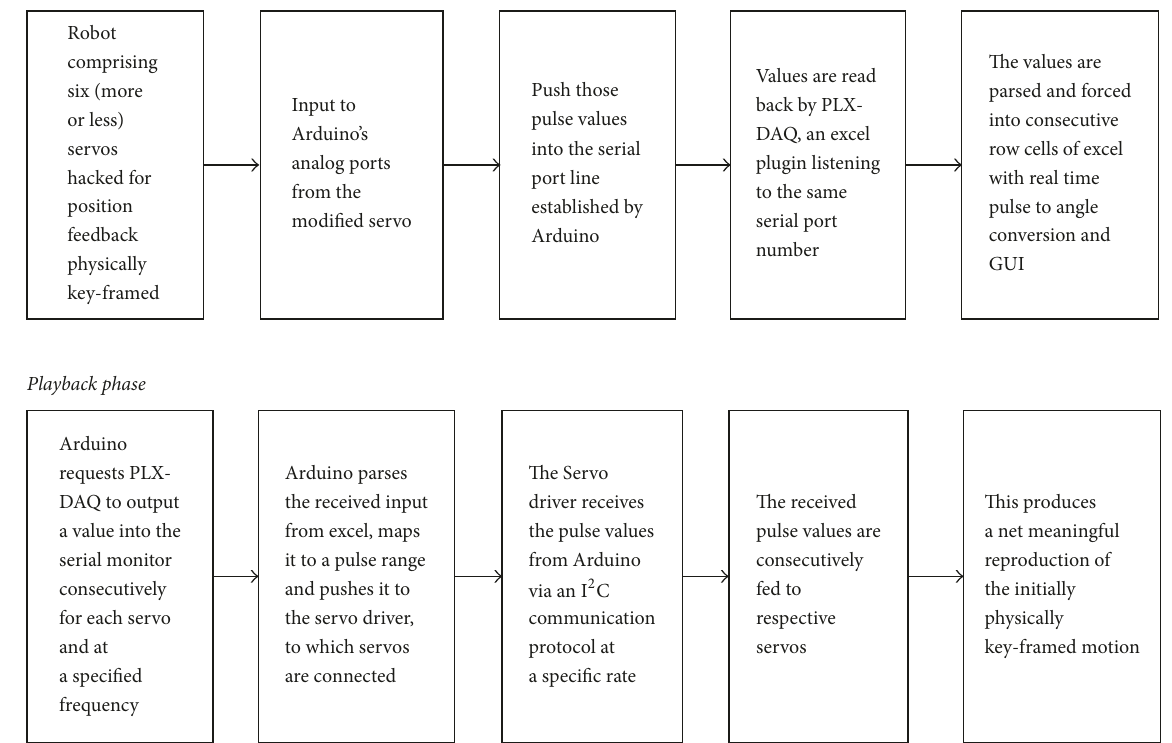
Figure 3: Logical activity flow during different phases of system operation.